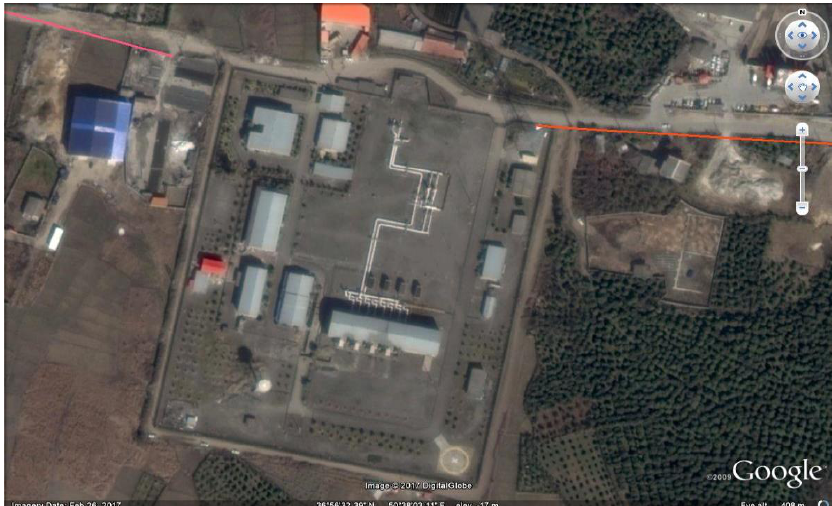
Figure 2. Ramsar gas booster